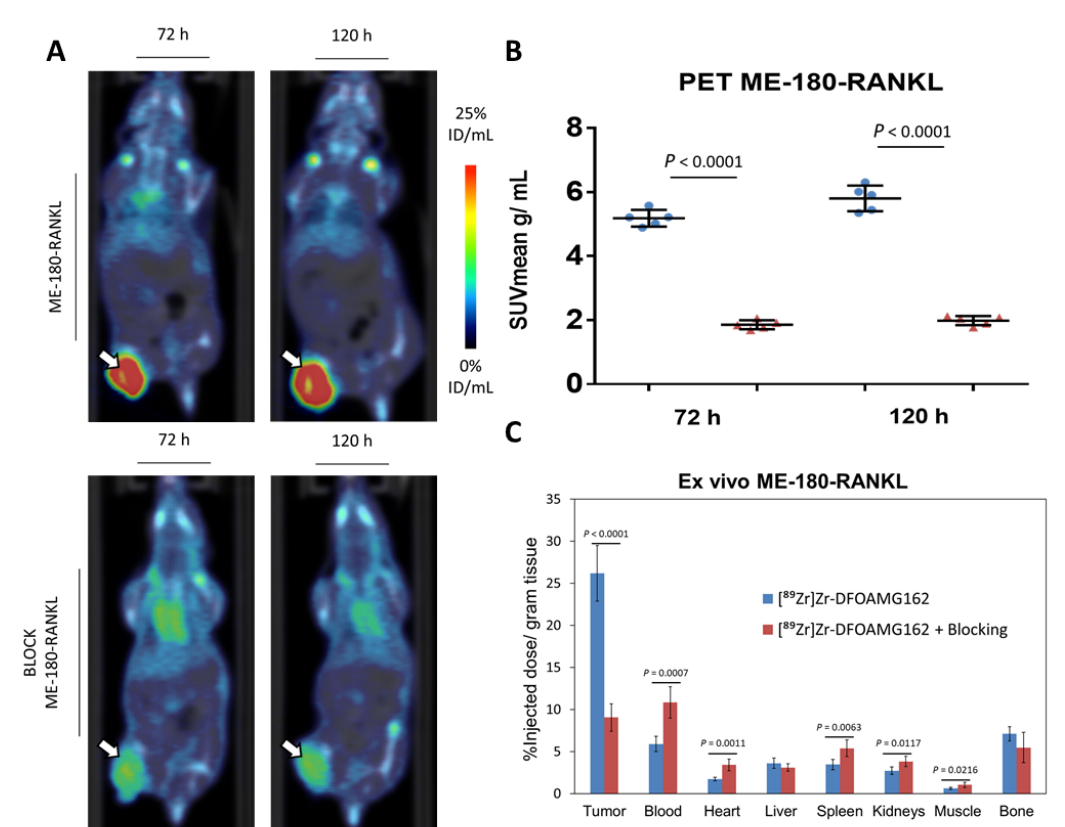
Figure 2. Overview imaging studies in ME-180-RANKL xenografts. ( A ) [ 89 Zr]Zr-DFO-AMG162 PET imaging 72 h and 120 h post injection in ME-180-RANKL non-blocked (top) and blocked (bottom) xenografts (arrows). ( B ) Difference in tumor uptake (SUV mean g/mL) assessed via PET between ME-180-RANKL xenografts treated without or with blocking dose at 72 h and 120 h p.i. ( C ) Ex vivo assessment of [ 89 Zr]Zr-DFO-AMG162 biodistribution (% ID/g) at 120 h p.i. (Blue bars: [ 89 Zr]Zr-DFO-AMG162 in non-blocked ME-180-RANKL xenografts, Red bars: [ 89 Zr]Zr-DFO-AMG162 in blocked ME-180-RANKL xenografts, Animals per timepoint in both groups: n = 5, Data graph: mean +/ − 1 standard deviation, White arrows: tumor, SUV mean : mean standard uptake value, ID/mL: injected dose/mL, Statistical analysis: unpaired student t -test).